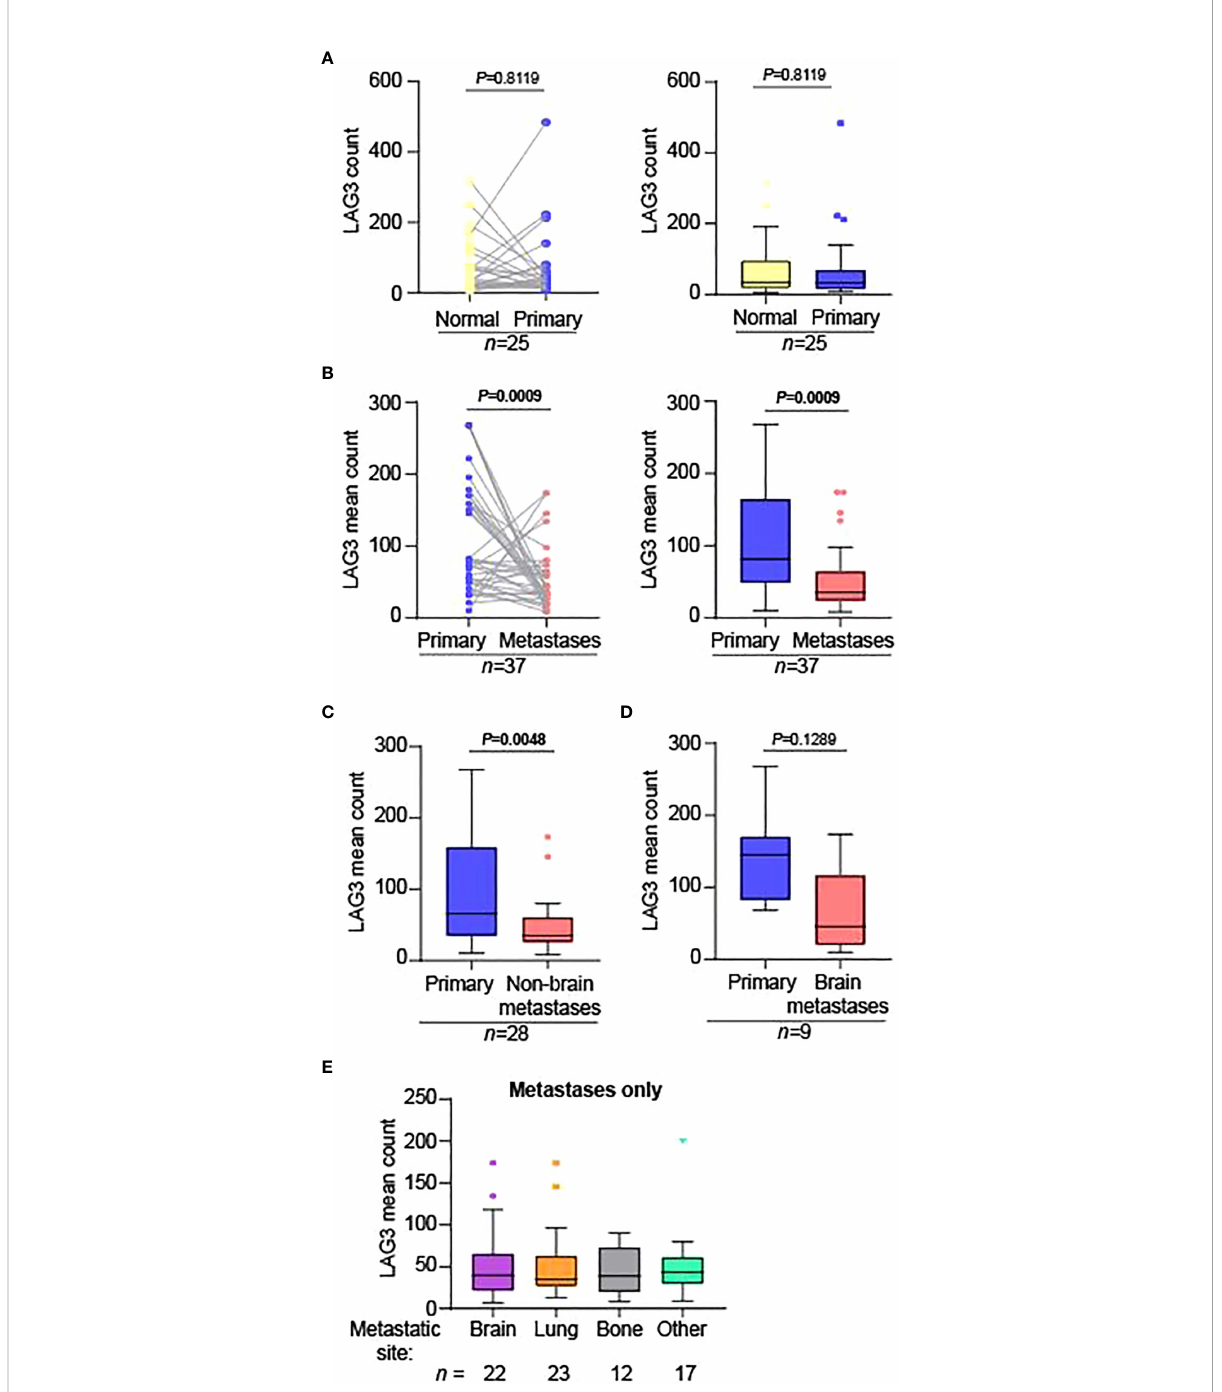
FIGURE 2 LAG3 levels are signi fi cantly lower in metastases compared to primary tumors. Matched-pair analysis comparing the normalized LAG3 counts in (A) normal adjacent kidney ( “ Normal ” ) to primary tumors ( “ Primary ” ) and (B) primary tumors to metastases. The graphs in the left and right panels represent the same data displayed differently; the graphs in the right panels are Tukey plots. Matched-pair analysis comparing the normalized mean LAG3 counts in primary tumors to (C) non-brain and (D) brain metastases separately. For parts (B-D) , when there were multiple metastatic specimens from the same patient on the TMA, they were each compared to the corresponding primary tumor separately. The n-sizes displayed represent the number of primary tumor to metastasis pairings, from (B) 28, (C) 22, and (D) 6 unique patients. (E) Tukey plot showing the normalized mean LAG3 counts across different anatomic sites of metastases only. There were no signi fi cant differences between the groups. For parts (A-D) , matched-pair analysis was performed using the non-parametric Wilcoxon test. For part (E) , the non-parametric Kruskal-Wallis test was performed comparing the means of all